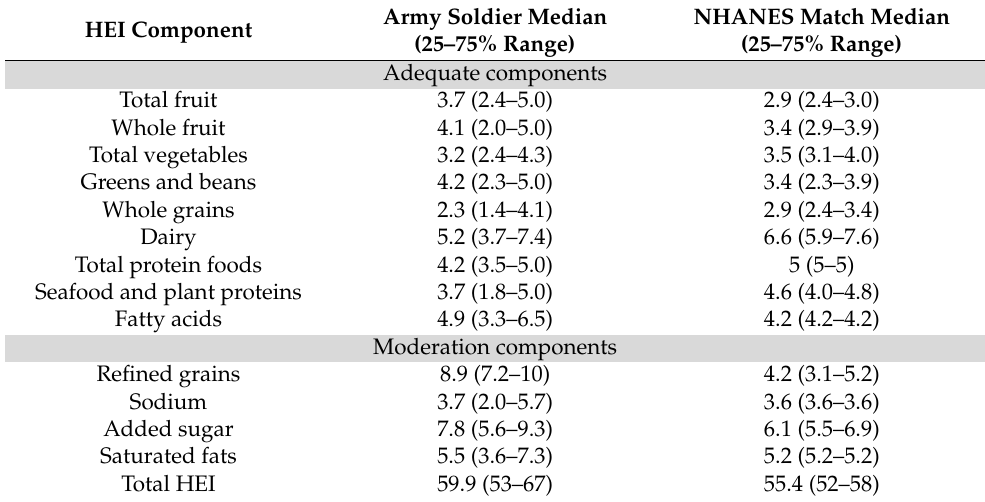
Table 4. Comparison of median HEI scores for Army soldiers and NHANES match for